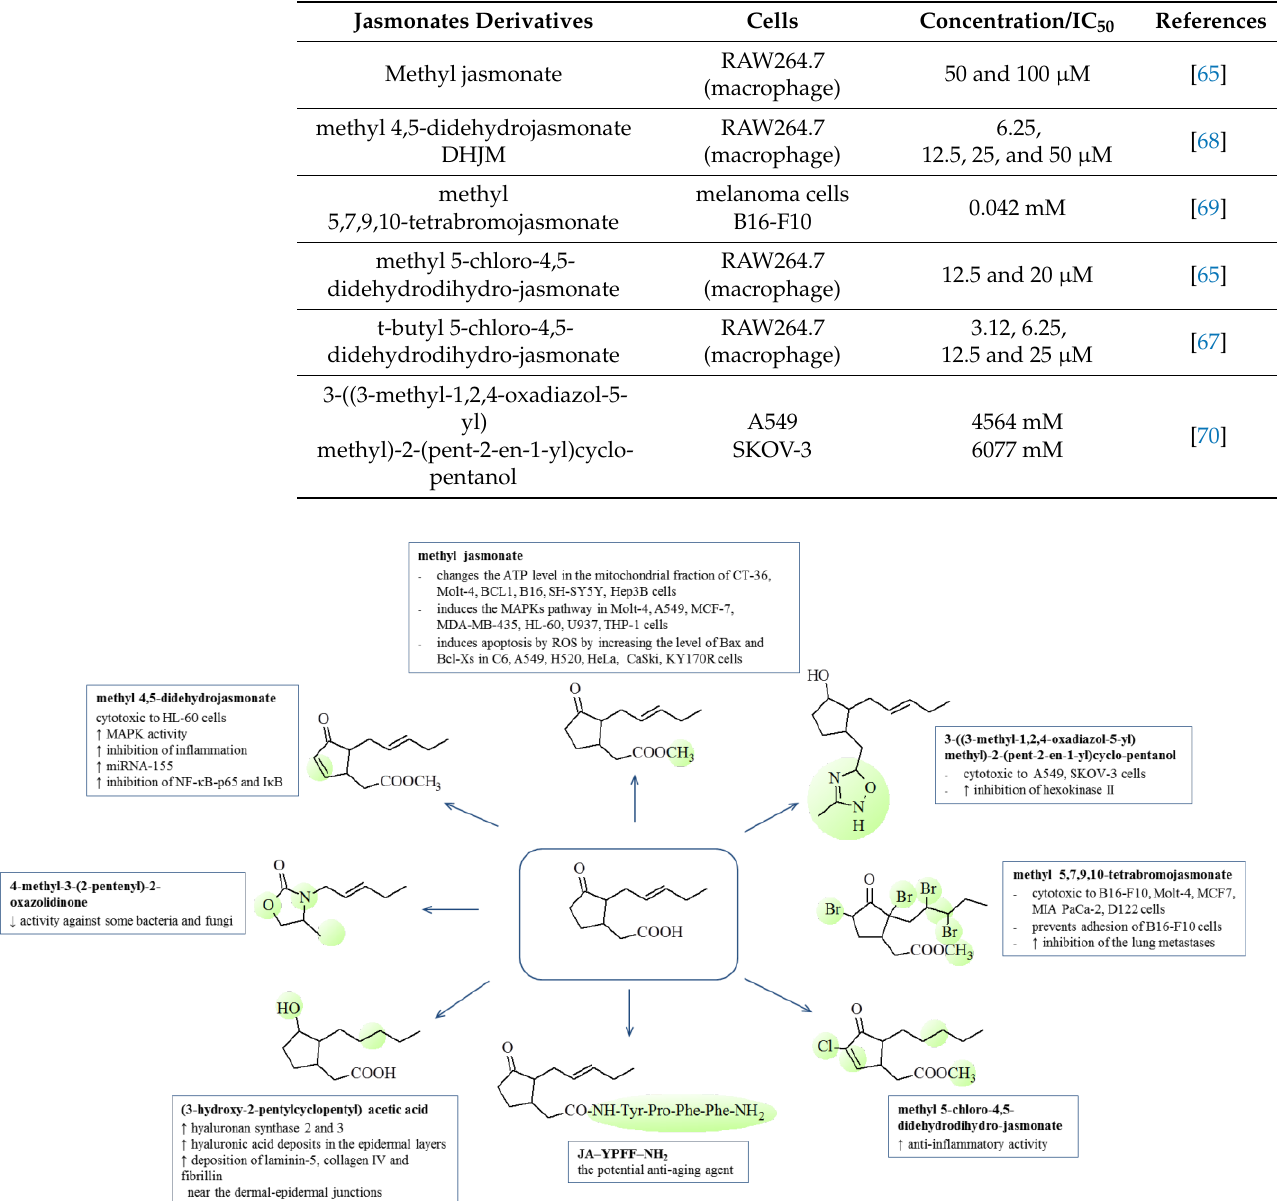
Figure 6. Biological activity of new jasmonate derivatives. [ ↓ , decreased activity; ↑ , increased activity].